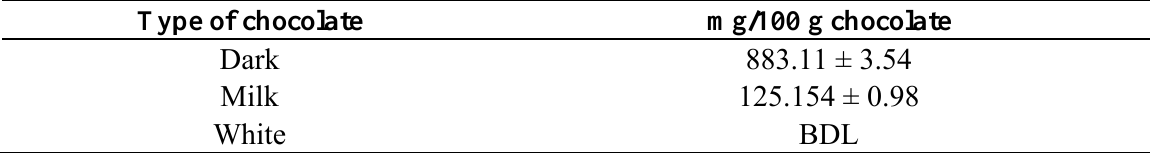
Table 2 : Theobromine in different types of commercial